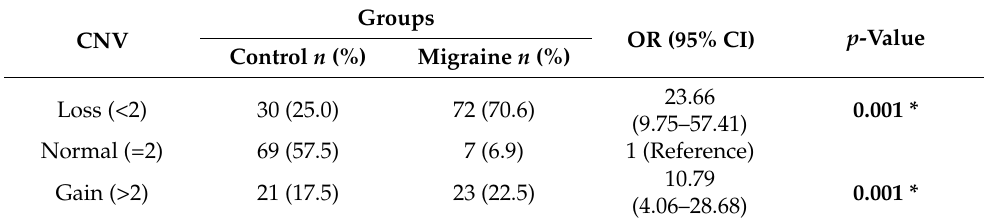
Table 4. CHRNA7 gene CNV and p -values in migraine patients and control group. Groups CNV